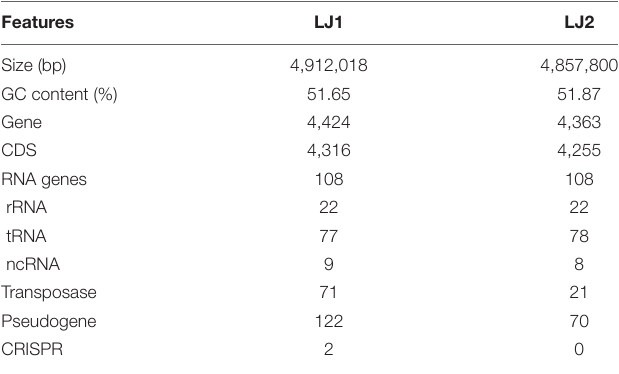
TABLE 1 | Genomic features of LJ1 and